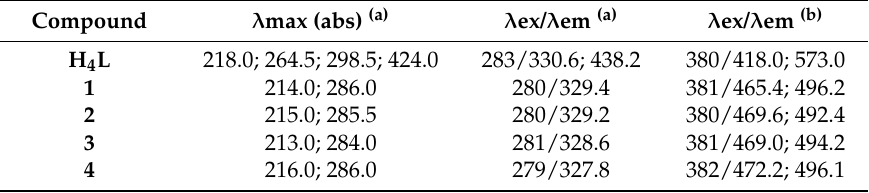
Table 2. Photophysical parameters of studied complexes 1 – 4 and H 4 L ligand (in nm).